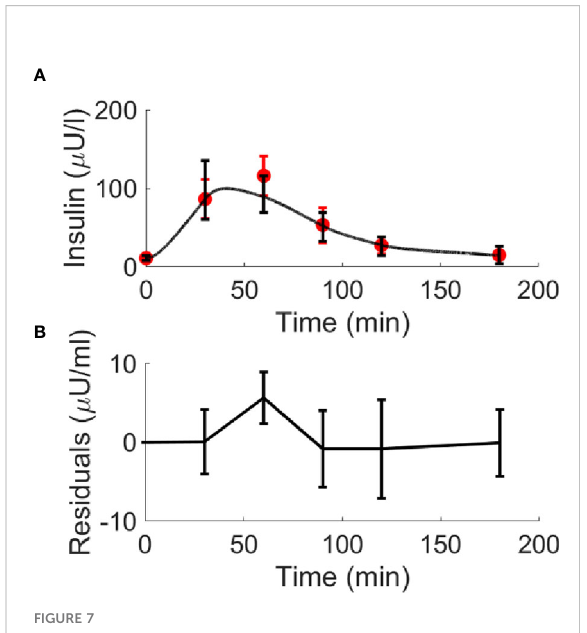
FIGURE 7 Best- fi t results for model validation on the 100 virtual CNT individuals. Red circles represent the mean (± SD) over the 100 individuals, whereas black continuous line represents the mean predicted insulin curve (panel A ); mean residuals over the 100 curves are also reported (panel B ).